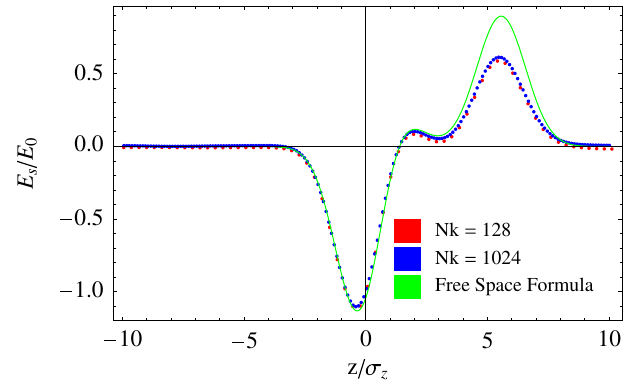
FIG. 11. (Color) Using parameter set D, varying the number of Fourier coefficients (Nk) used in the A&Y calculation does not change the numerical solution of the Maxwell equations, and therefore does not account for deviations in the presented com- parison of codes.